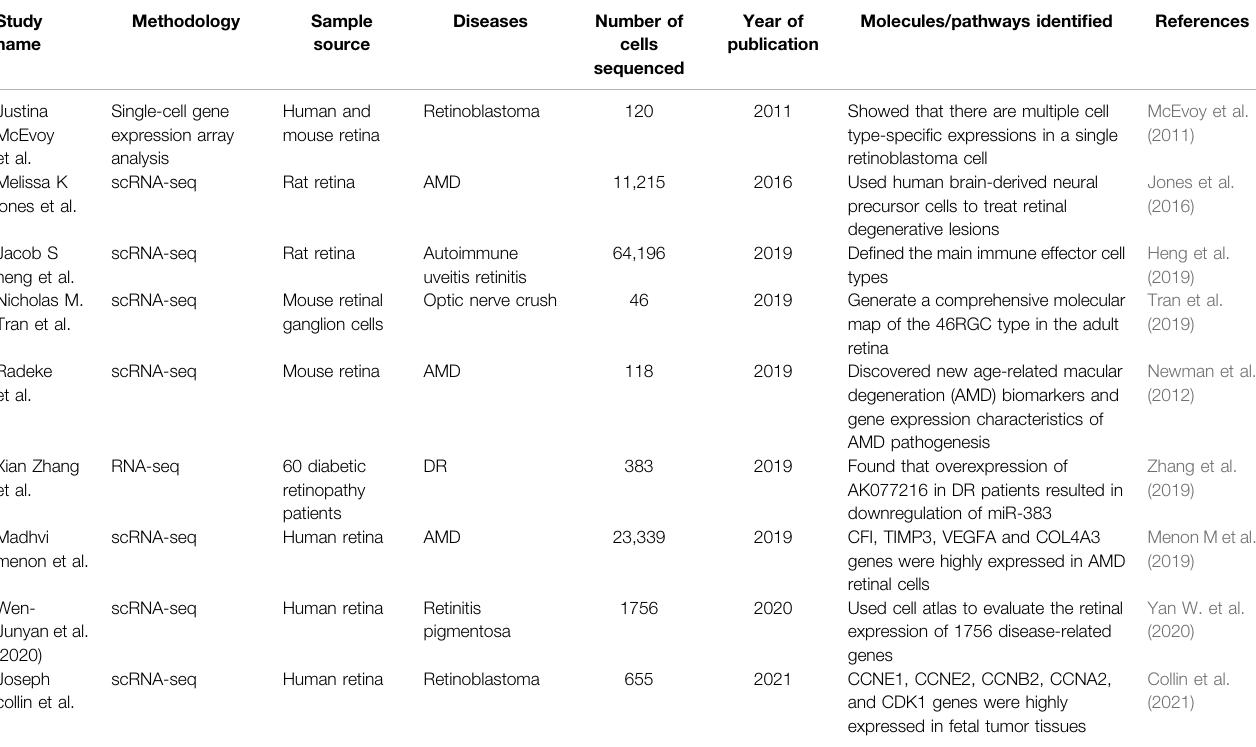
TABLE 3 | Studies of gene expression in retina